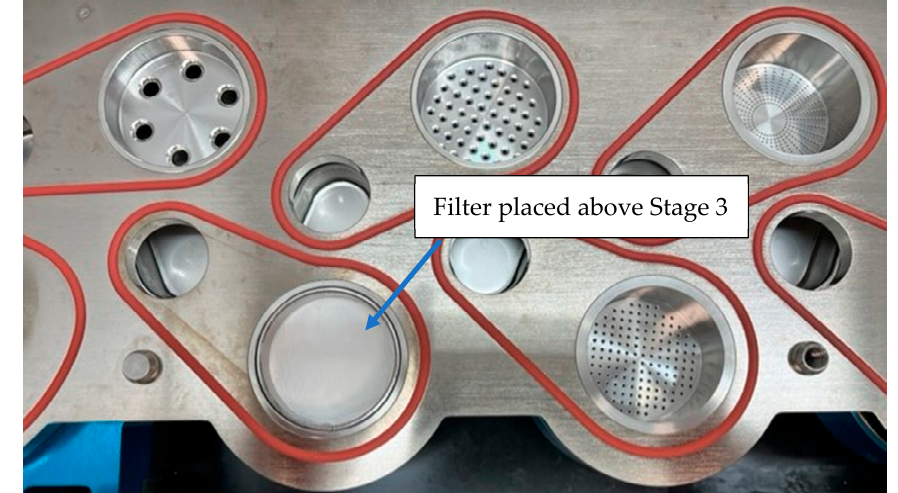
Figure 10. A glass fi ber fi lter is located on stage 3 of the NGI.